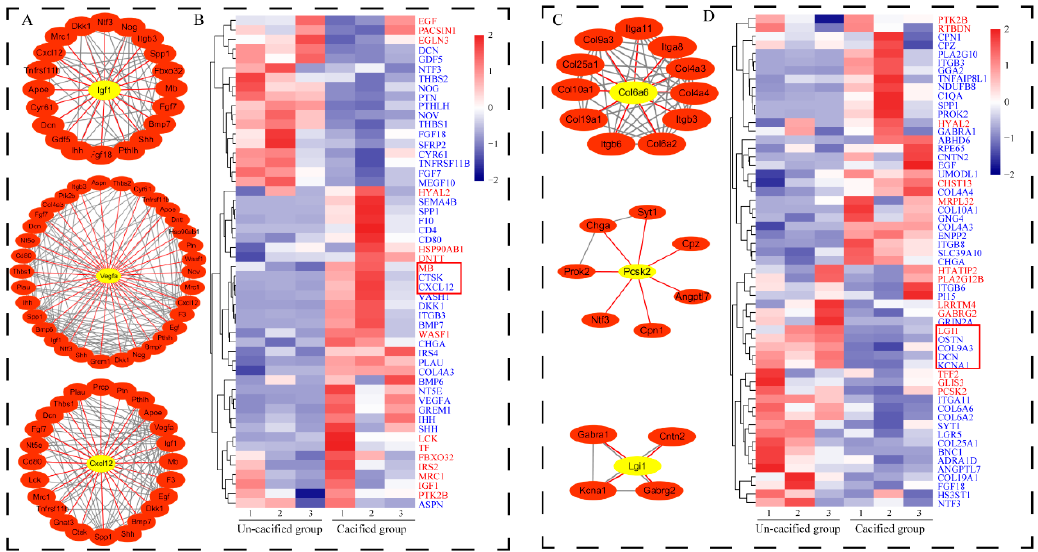
Figure 7. Map of protein–protein interaction (PPI) networks and a gene expression cluster analysis between the secretory proteins and differential expressed genes. ( A ) PPI network between the sternum secretory protein and the pectoral muscle differential gene. ( B ) Gene expression cluster of all genes selected from PPI networks (Figure 7A). Different groups of genes are distinguished by different colors, in which red represents DEGs from muscles and blue represents secretory proteins from bones. ( C ) PPI network between the proteins secreted from the pectoral muscle and the differential expressed genes in the calcified and un-calcified sternum. ( D ) Gene expression cluster analysis of all genes selected from PPI networks (Figure 7C). Different groups of genes are distinguished by different colors, in which red represents secretory proteins from muscles and blue represents DEGs from bones.